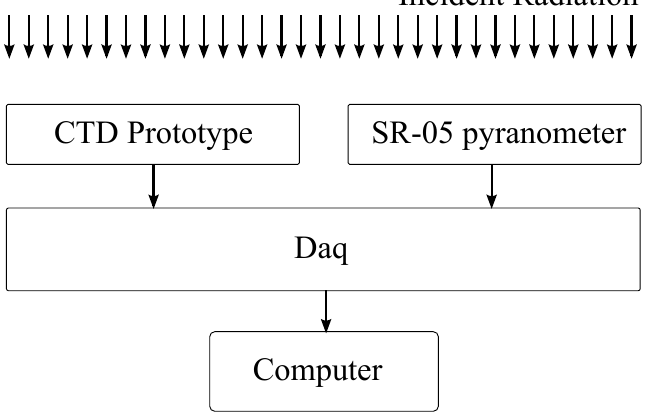
Figure 5. The setup diagram of performed experiments.